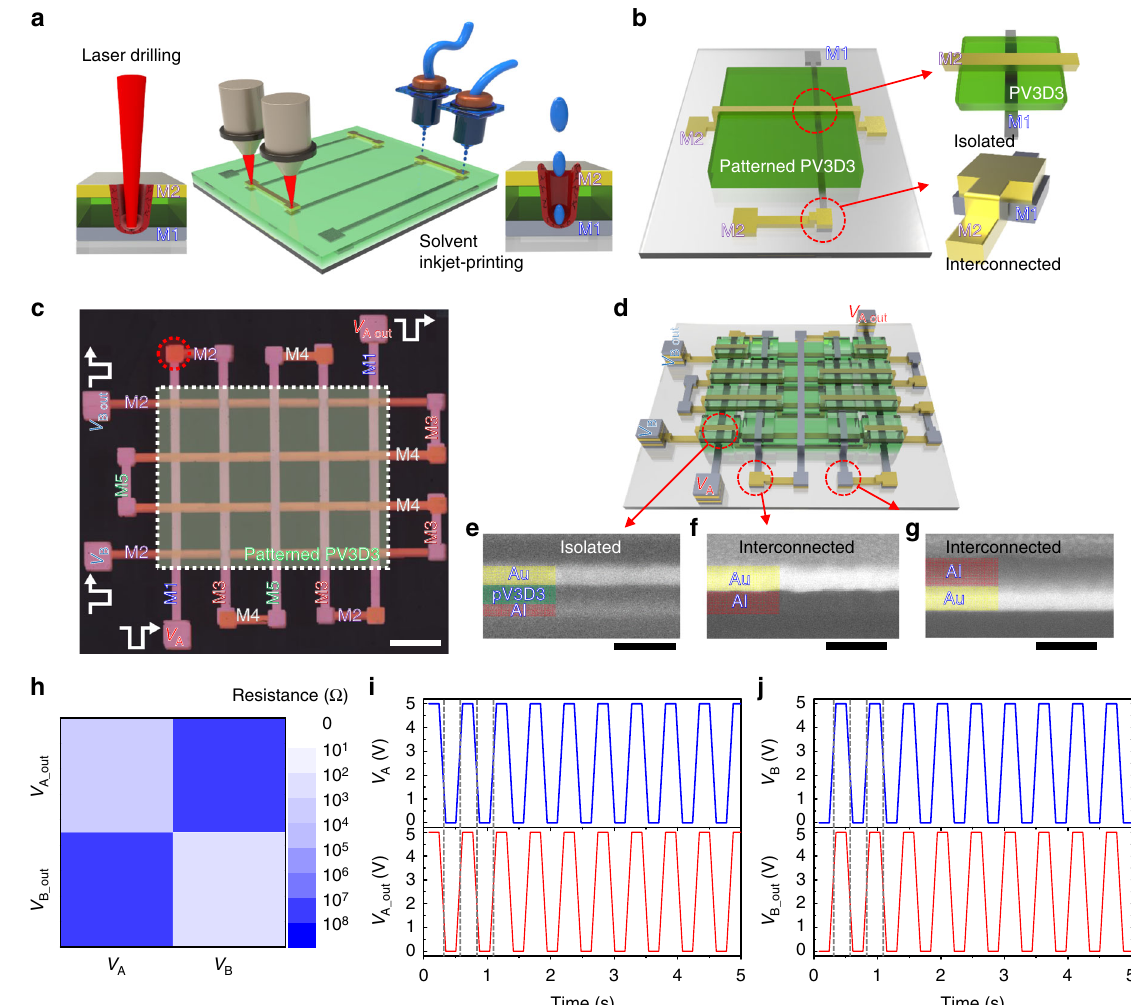
Fig. 1 Multilevel metal interconnect scheme. a Schematic of metal interconnect methods using laser drilling and solvent inkjet printing. b Schematic of the metal interconnect method using patterned PV3D3 layers. c An optical microscopy image of the fabricated multilevel metal interconnect test structure. The scale bar indicates 1200 µ m. d Schematic of the multilevel metal interconnect test structure. Cross-sectional SEM images of e an isolated metal electrode (M1 and M2), scale bar, 100 nm, f an interconnected metal electrode (M3 and M4), scale bar, 100 nm, and g an interconnected metal electrode (M2 and M3) scale bar, 100 nm. h A mapping image of the resistance values among V A , V A_out , V B , and V B_out . i Output voltage response ( V A_out ) with respect to the input voltage pulse ( V A ). j Output voltage response ( V B_out ) with respect to the input voltage pulse ( V B